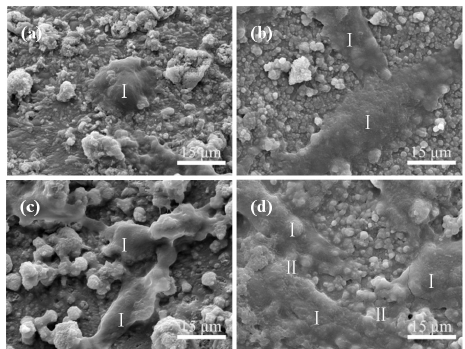
Figure 11. Scanning electron microscopy (SEM) images of cells cultured on the CaSO 4 scaffolds with: ( a ) 0 wt % (control) and ( c ) 5 wt % 45S5 bioglass for one day; ( b ) 0 wt % (control) and ( d ) 5 wt % 45S5 bioglass for three days. I: cells. II: cell ‐ cell junctions.